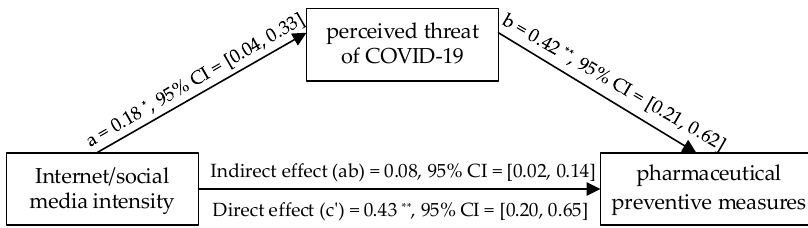
Figure 4. Results of the mediation model. Note: n = 218. * p < 0.05, ** p < 0.01.